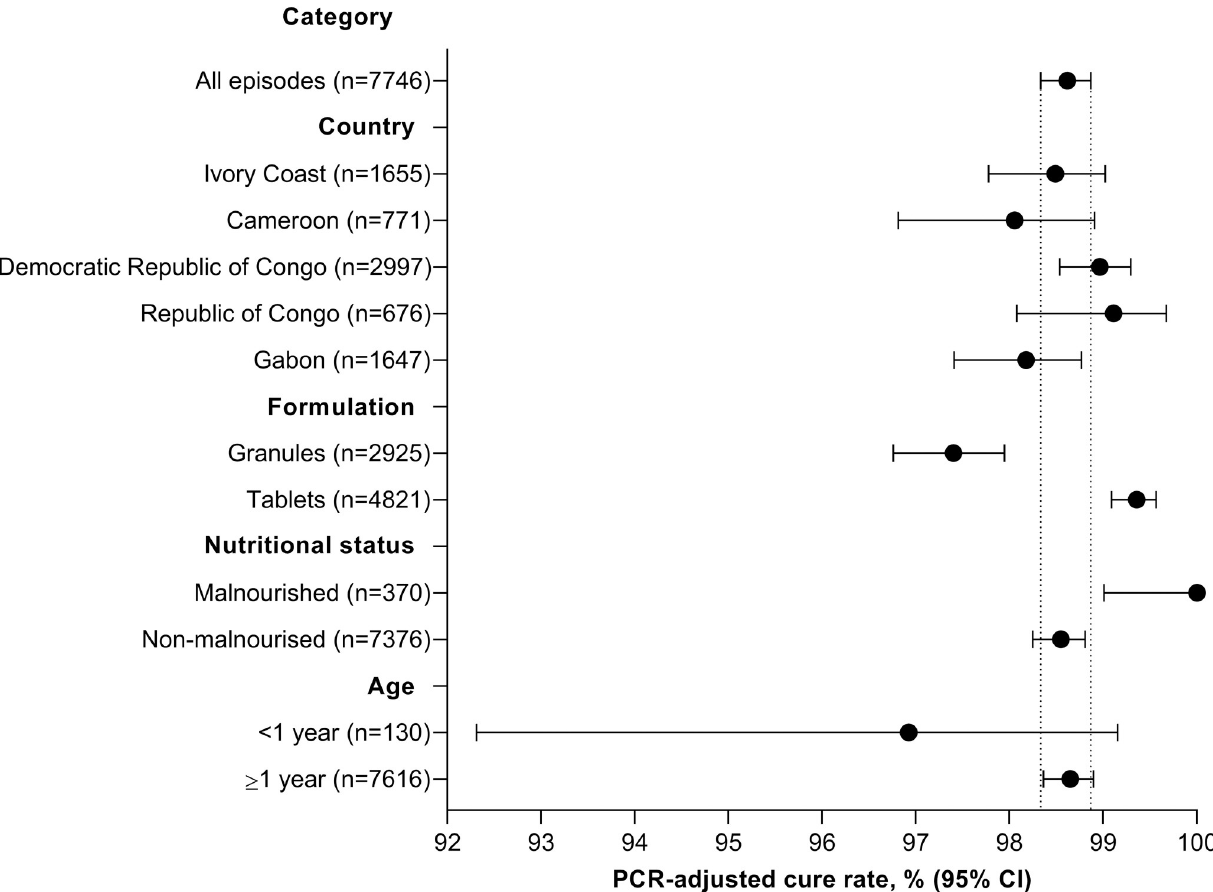
Fig 3. Day 28 PCR-adjusted treatment effectiveness in the per-protocol population subgroup analysis. Data are shown for the number of malaria episodes. CI, confidence interval; PCR, polymerase chain reaction.